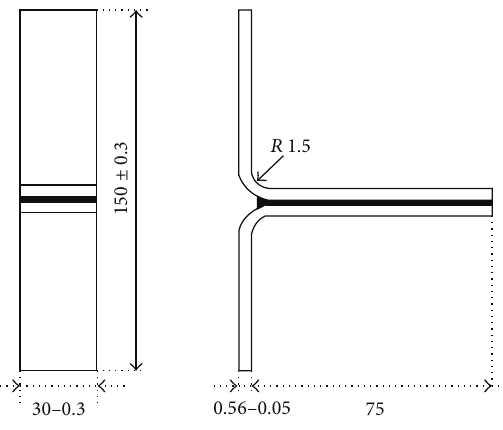
Figure 3: SEM image of cross section of the zinc coating on steel substrate.